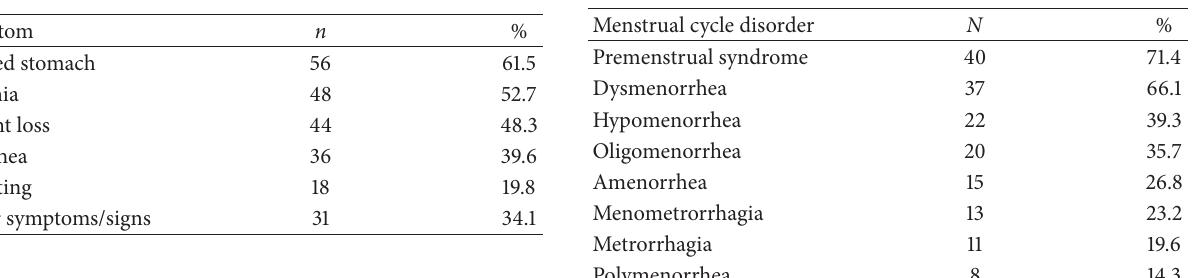
Table 2: Type and frequency of celiac disease symptoms of onset, Italy, 2008.